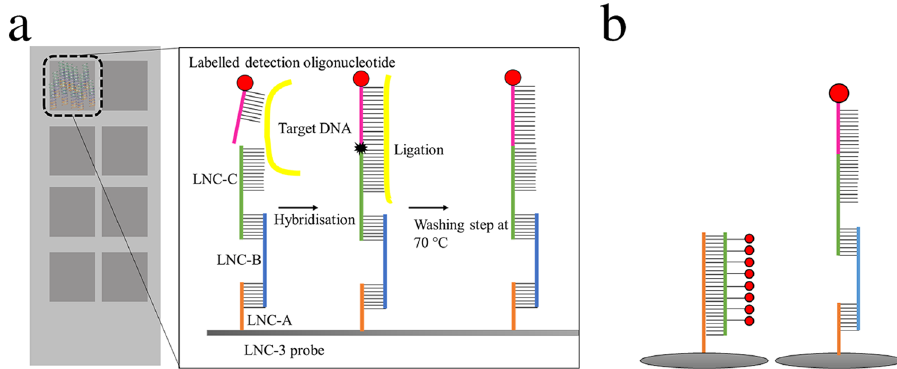
Figure 1. ( a ) Chip surface: Schematic representation of the 8 array chambers with the linear nucleotide chain (LNC-3) concept: To mimic liquid phase DNA hybridisation, three oligonucleotides, specified as LNC-A (orange), LNC-B (blue), and LNC-C (green), are immobilised on a functionalised glass surface (grey), the first one covalently, the others by hybridisation. The LNC-C terminal region is complementary to one part of the target DNA (yellow). The other part is complementary to the detection oligonucleotides (magenta), which are biotinylated and can be stained by fluorescence-labelled streptavidin (red). Once connected via the target DNA, LNC-C and detection oligonucleotide are ligated, thereby covalently linking the detection oligonucleotide to the immobilised probe. By washing at 70 °C, non-ligated detection oligonucleotides are removed. ( b ) Comparison: Identification via conventional, hybridisation-based detection (left) and LNC-3 technology